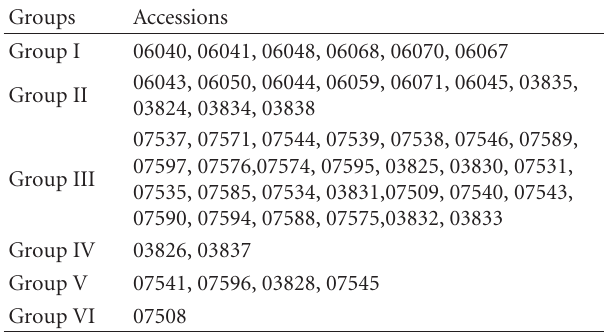
Table 7: Groups of upland rice accessions according to cluster